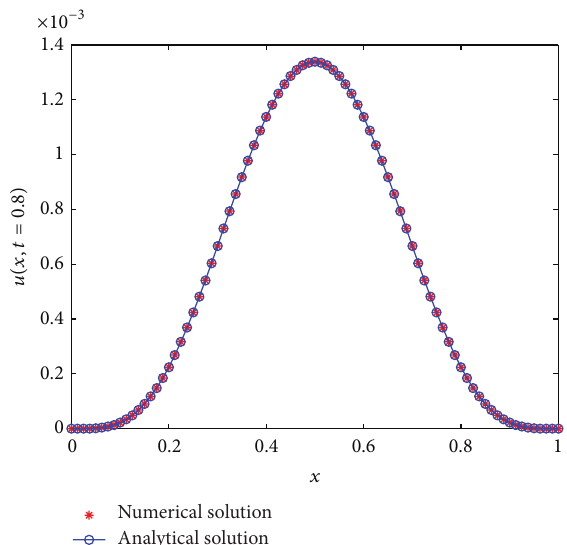
Figure 2: Comparison between the analytical solution and the numerical solution at 𝑡 = 0.8 with 𝛼 = 1.9 in Example 3 (𝜏 = 1/100, ℎ = 1/80) .